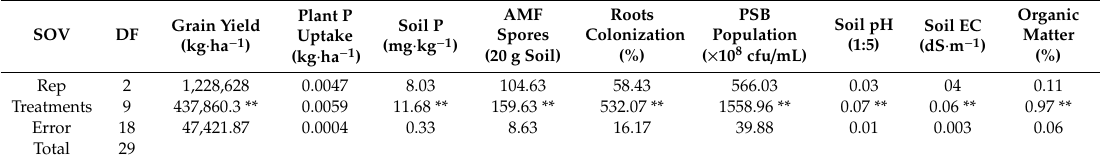
Table 2. Mean square values for the soil and plant parameters as influenced by the applied AMF and PSB with RP in maize